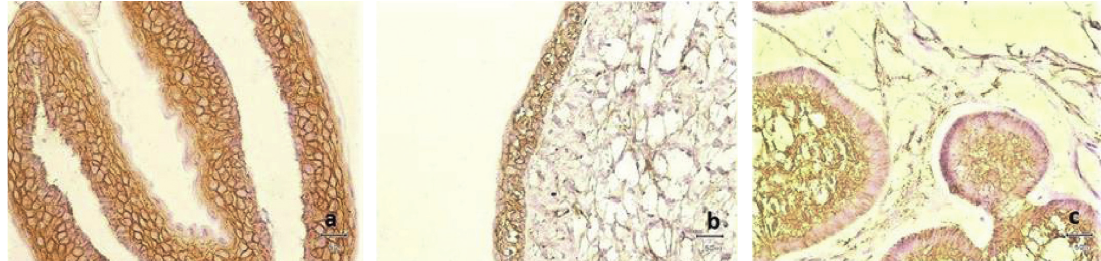
Figure 2: Immunohistochemical expression of syndecan-1 (a) in OKC epithelial lining, (b) in DC epithelial lining, and (c) in AB (original magnification × 400).